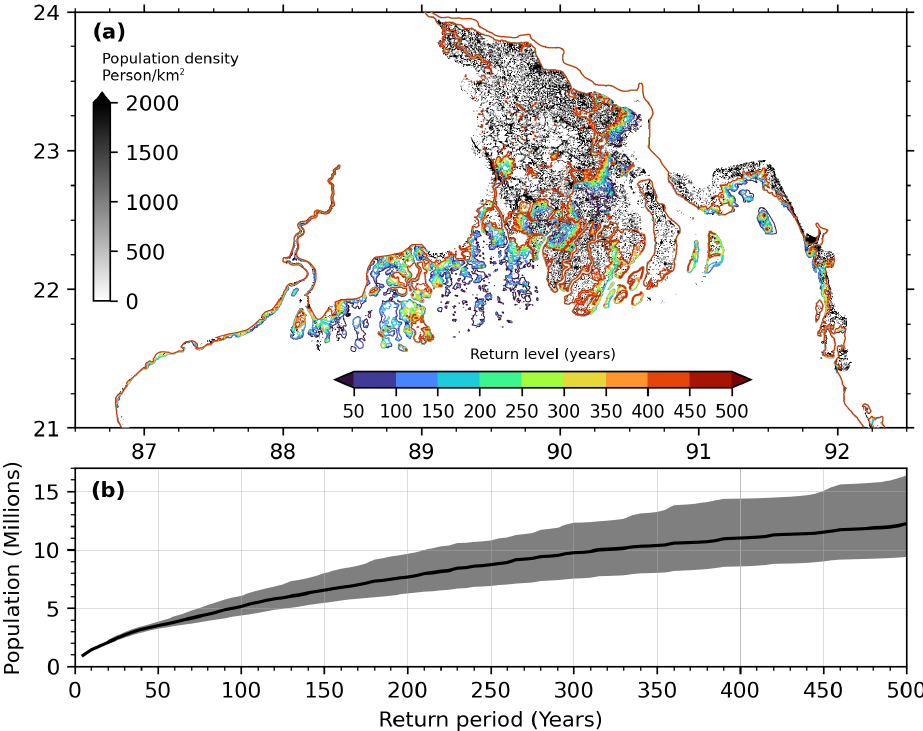
Figure 9. (a) Spatial coverage of flooding at various n -year return periods estimated from the model. The grey colour bar shows the population density per square kilometre. (b) Number of people affected at various n -year water level return periods. The shaded area shows the 95% confidence